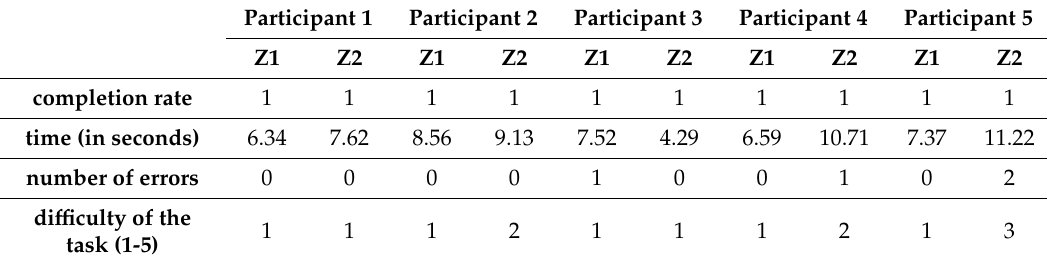
Table 3. Usability test results for a Prototype B (e ff ectiveness and e ffi